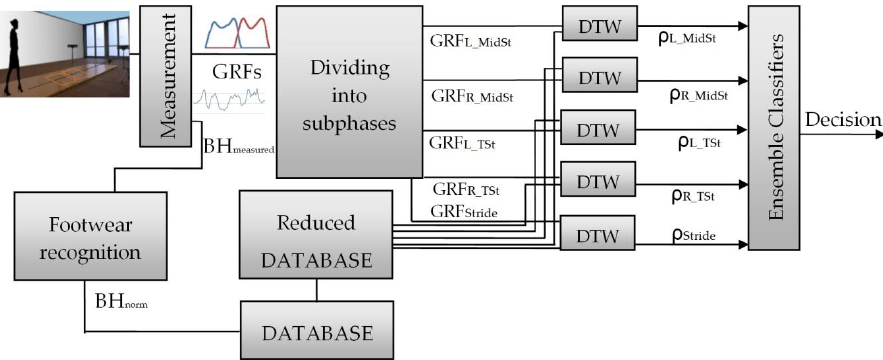
Figure 6. The scheme of the experiment.